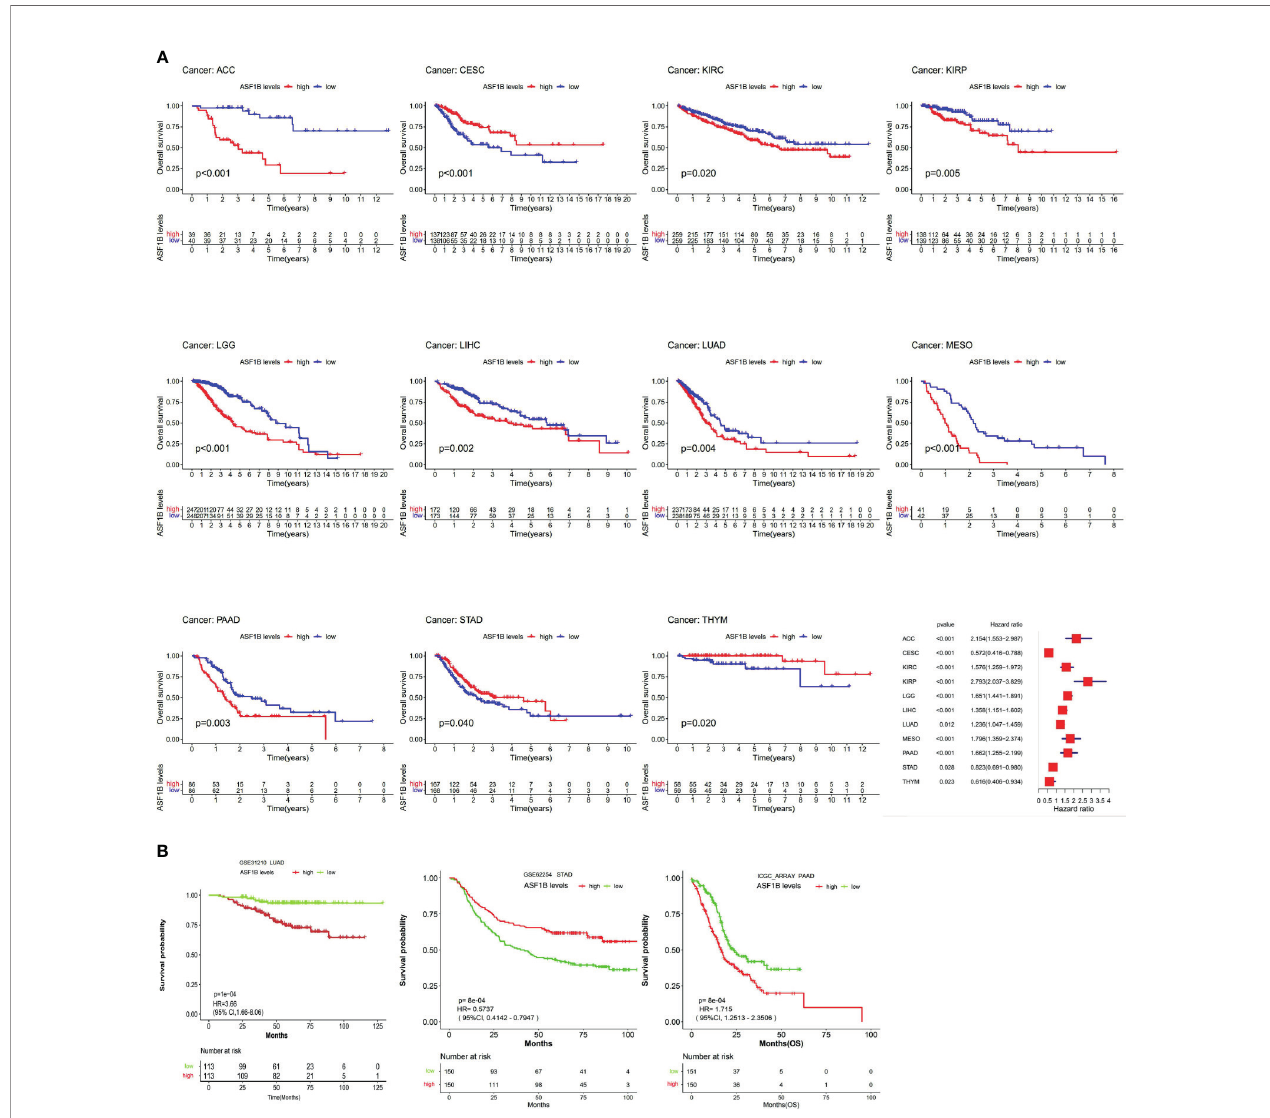
FIGURE 2 | The association between ASF1B expression and cancer patient prognosis. (A) The correlation between ASF1B expression and the prognosis of various cancer types were evaluated by The TCGA database. (B) The Relationship between ASF1B expression and the prognosis of various cancer types were